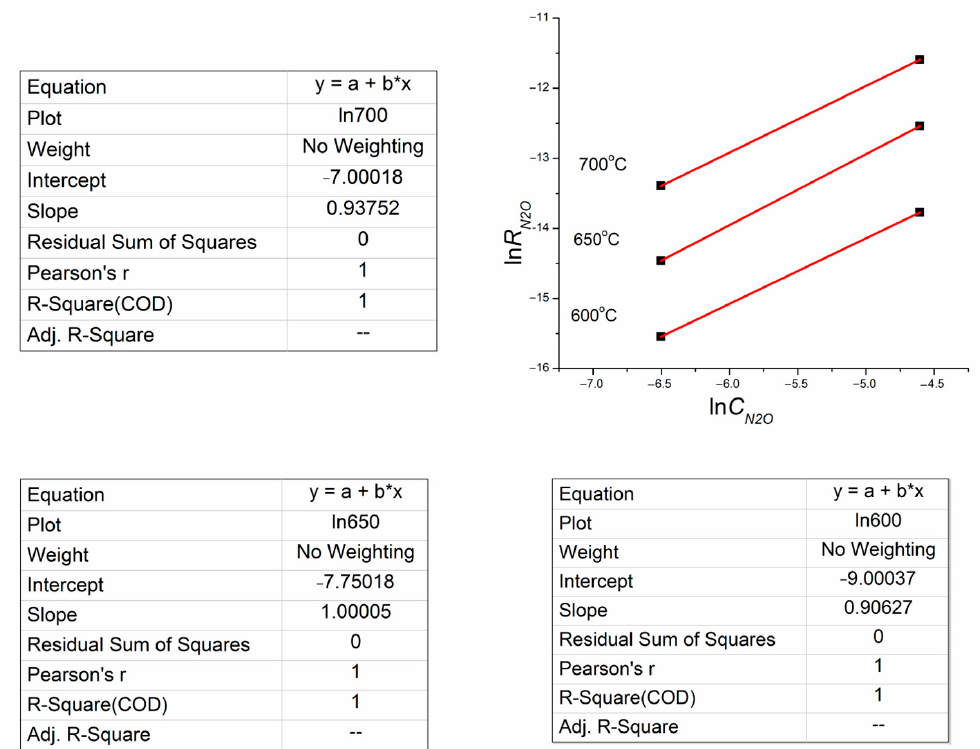
Figure A1. Dependence of the logarithm of the reaction rate on the logarithm of N 2 O concentration (% vol) at different temperatures.